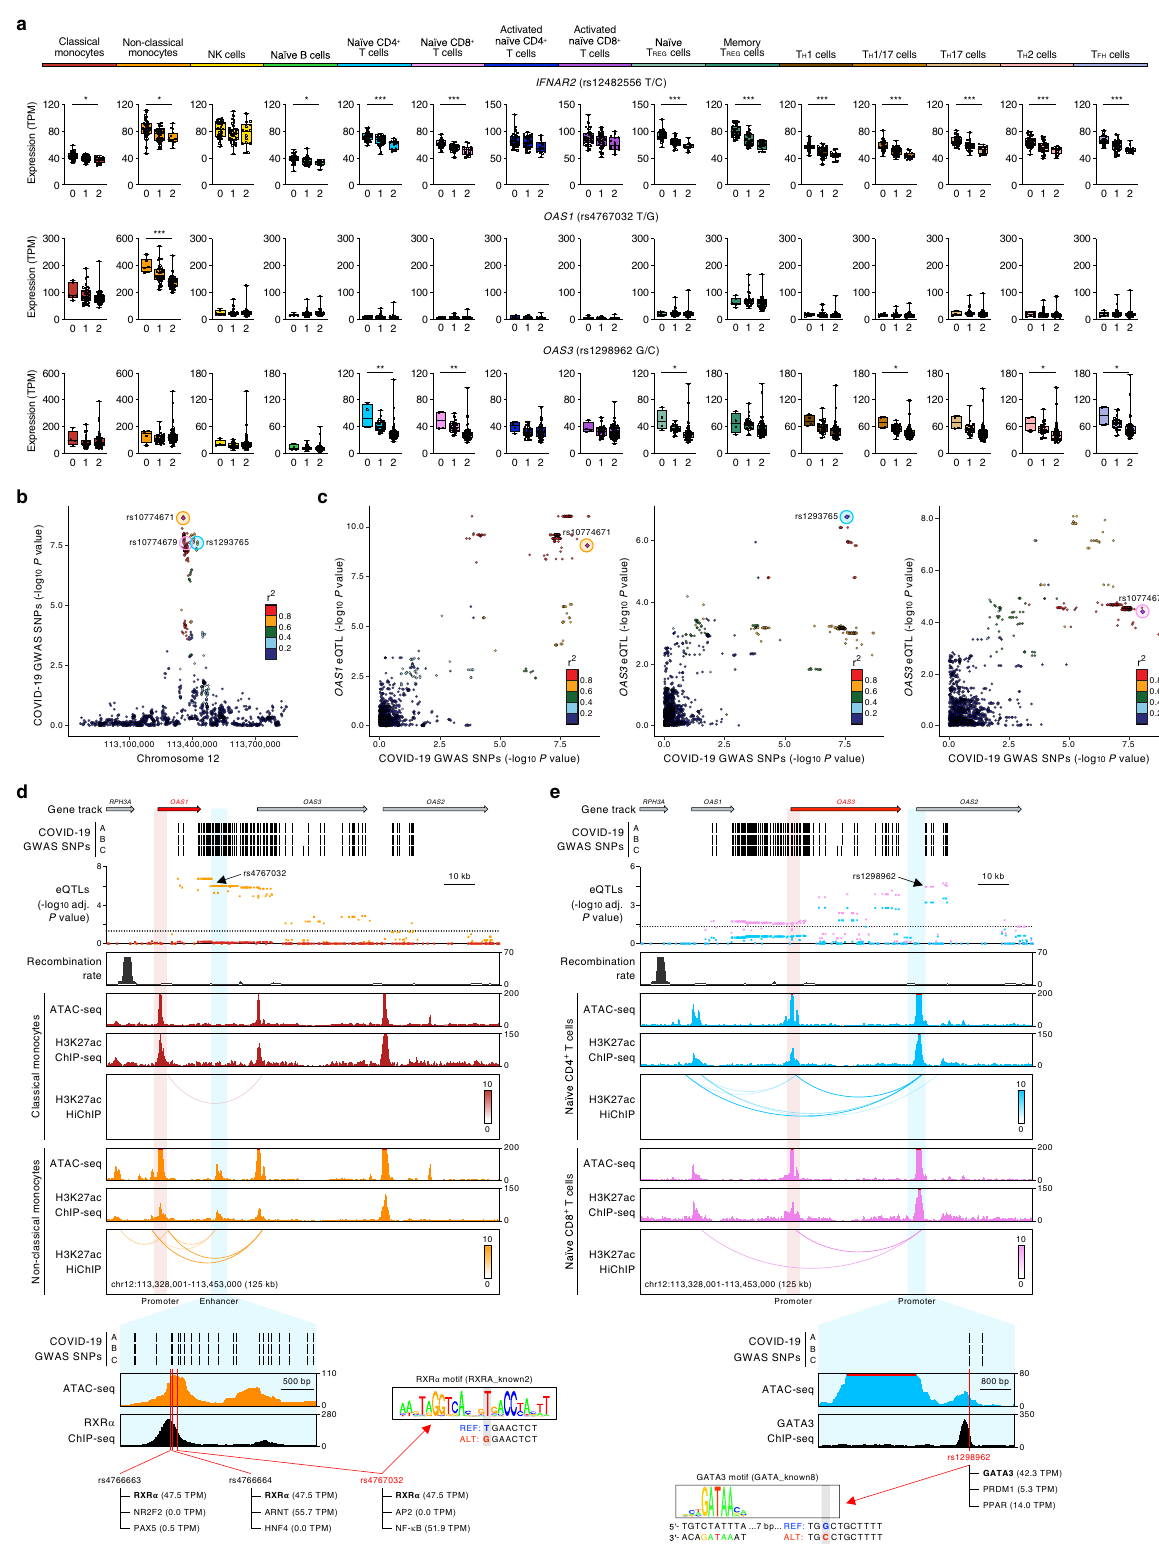
three independent binding sites for retinoid X receptor alpha (RXR α ), which has also been shown to bind to this DNA region (ENCODE Transcription factor ChIP-seq in liver tissue and liver cell lines 36 ) (Fig. 2d, bottom panel). Given the recognized role of RXR α in regulating gene expression in monocytes 37 , we speculate that perturbation of RXR α binding to the NCM-speci fi c cis -